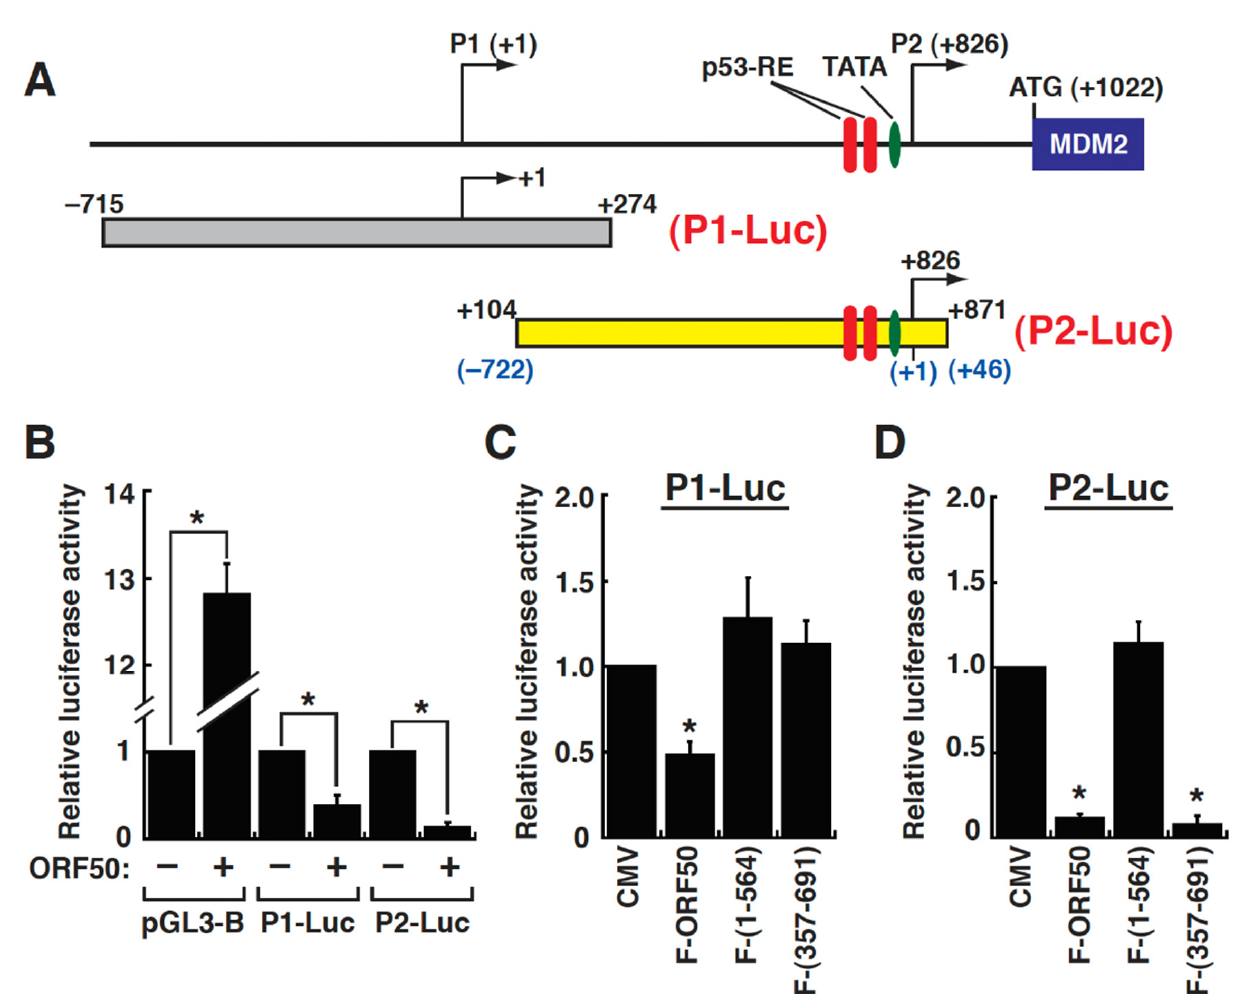
Figure 4. Analysis of the regulation of both the MDM2 P1 and P2 promoters using luciferase reporter gene assays. ( A ) Schematic diagram of the reporter constructs with the P1 or P2 promoter of the MDM2 gene. The P1 promoter from –715 to +274 and the P2 promoter from –722 to +46 (or +104 to +871 with respect to the P1 transcription start site) were individually cloned into pGL3-Basic, resulting in the generation of P1-Luc and P2-Luc, respectively. Note that there are two p53-responsive elements (p53-RE) in the P2 promoter region. ( B ) Effect of ORF50 on the reporter gene expression of pGL3-Basic, P1-Luc, and P2-Luc in 293T cells. After 293T cells were cotransfected with the indicated reporter constructs and the ORF50-expressing plasmid or the empty vector control (CMV) for 30 h, cells were harvested and assayed for luciferase activity. *, p < 0.05, for results compared to those from the empty vector group (n = 3). ( C ) Repression of the MDM2 P1 promoter by ORF50 and its deletion mutants. The P1-Luc reporter construct was cotransfected with the indicated expression plasmids into 293T cells. At 30 h after transfection, cells were harvested, and luciferase activity was measured. *, p < 0.05, for results compared to those from the empty vector group. ( D ) Repression of the MDM2 P2 promoter by ORF50 and its deletion mutants. *, p < 0.05, for results compared to those from the empty vector group.